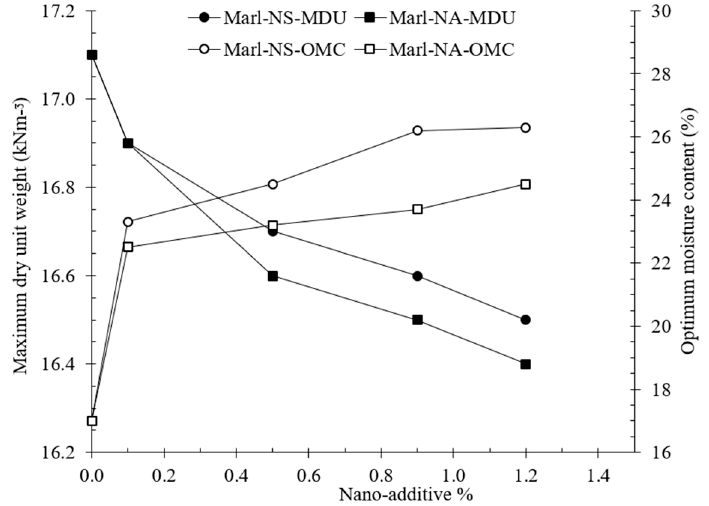
Figure 1. Maximum dry unit weight and optimum moisture content of nano-additive treated marl. Table 4. Standard Proctor compaction properties of the nano-cement stabilized marl. Adapted from [72].